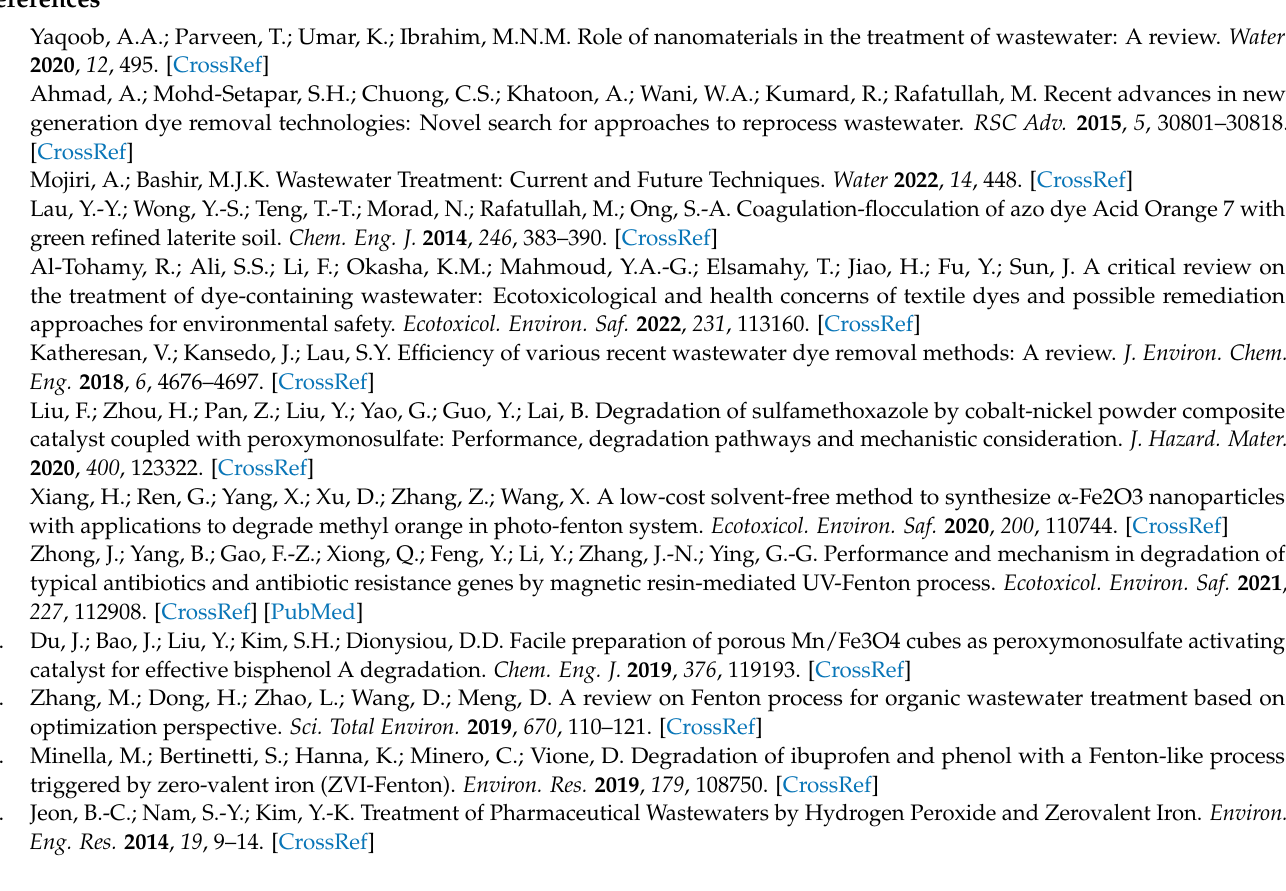
Table S1: BET-specific surface area results for iron